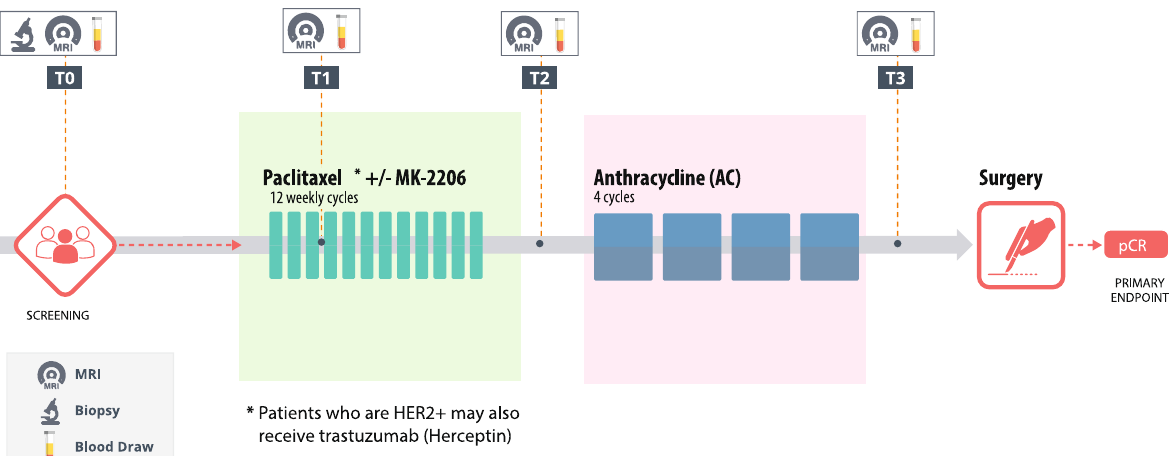
Fig. 5 Study schema showing time points for collection of MRI-based functional tumor volume (FTV) and circulating tumor DNA (ctDNA) data during neoadjuvant chemotherapy (NAC). Patients received paclitaxel-based treatment followed by anthracycline-based chemotherapy. Data and biospecimens were collected at pretreatment (T0), 3 weeks after initiation of paclitaxel-based treatment (T1), between paclitaxel and anthracycline regimens (T2), and after NAC prior to surgery (T3). Pathologic complete response (pCR), the primary endpoint of this study, was assessed at surgical time